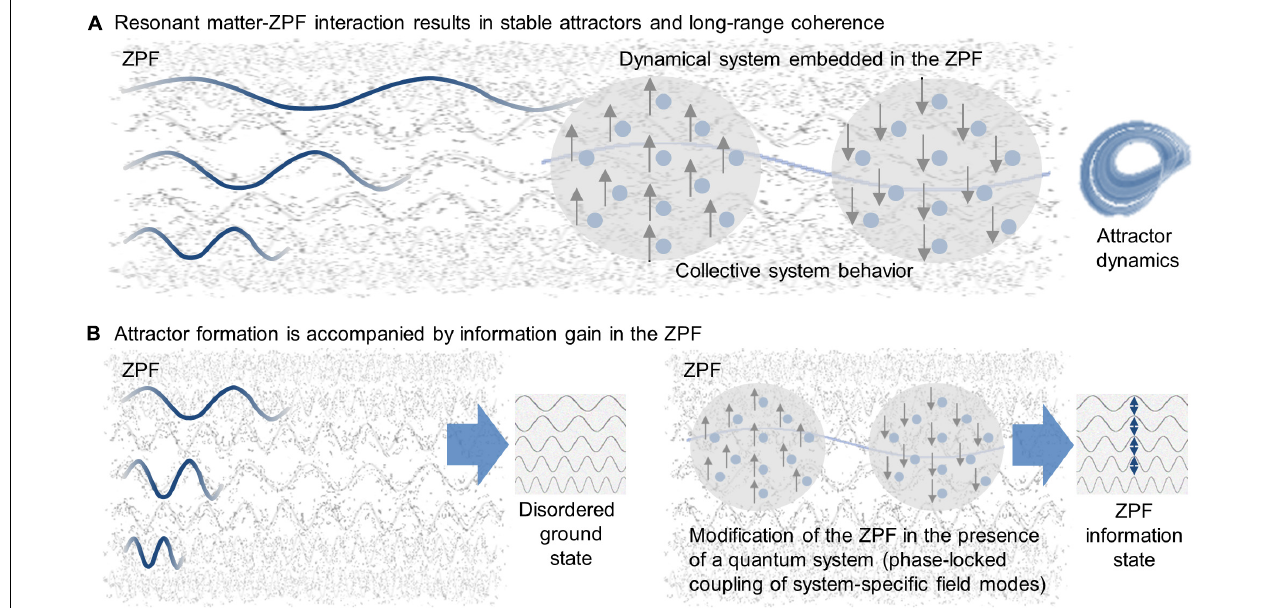
FIGURE 1 | Universal principles underlying quantum systems. (A) Every material system is embedded in the zero-point field (ZPF) that constitutes an omnipresent ocean of energy. Due to their continuous coupling with ZPF, the electrically charged building blocks of a system behave like driven oscillators. Sufficient shielding against disturbing effects provided, a system enters the quantum regime and falls into a stable attractor, each system being characterized by a specific set of resonance frequencies filtered out of the full ZPF spectrum. For many-body systems, the resonant interaction with the ZPF results in long-range coherence and collective system behavior. (B) While in its ground state the ZPF is a completely disordered field with uncorrelated field modes, the resonant interaction with a quantum system has repercussions on its internal structure. The formation of an attractor is accompanied by the phase-locked coupling of the set of field modes that correspond to the system’s resonance frequencies, resulting in an ZPF information state that has higher information content than the disordered ground state of the